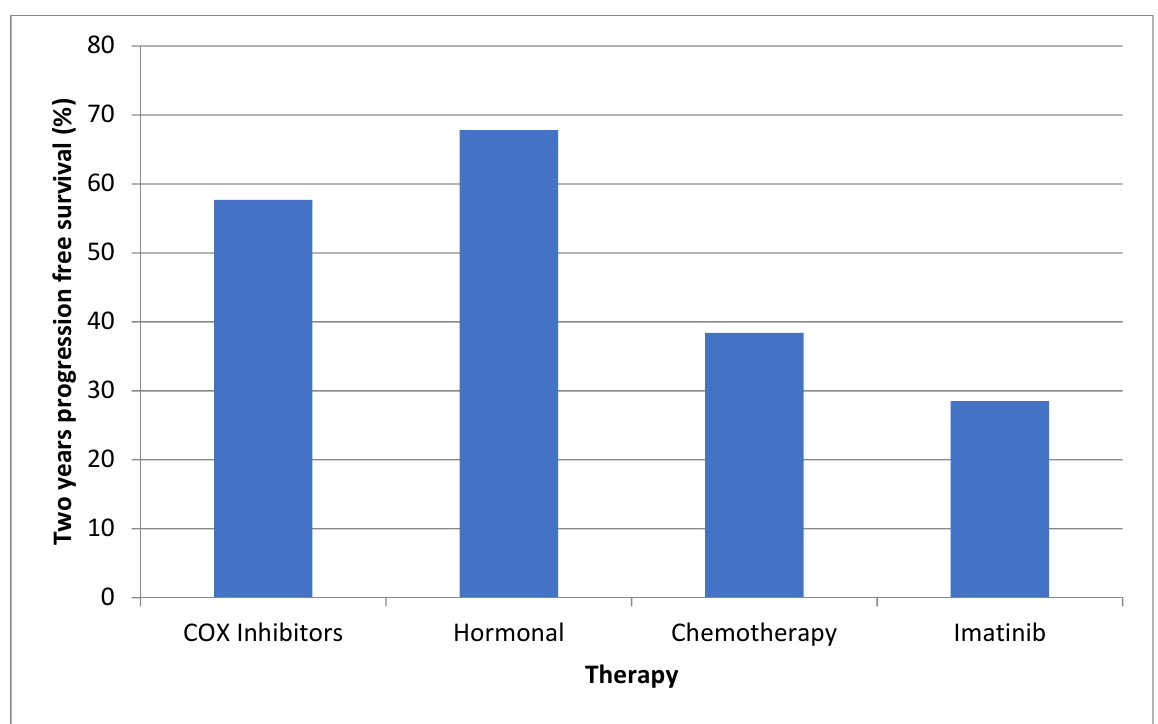
Figure 1. Two-year progression free survival according to different treatment modalities. Table 3. Prevalence, duration, and outcome of the different treatment modalities.